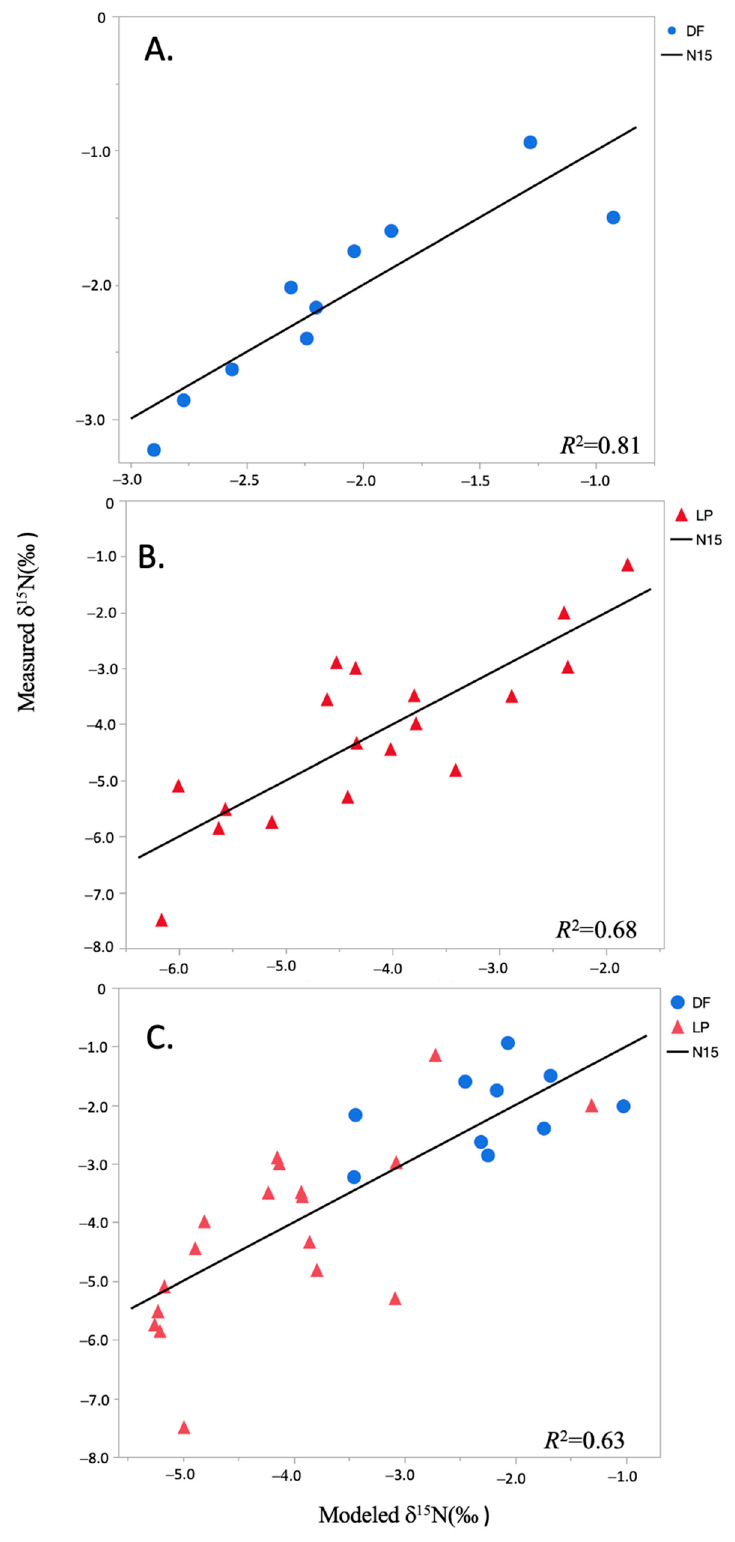
Figure 3. Multiple linear regression models predicting natural abundance foliar δ 15 N (‰) from leaf level spectroscopy for: ( A ) Douglas-fir (two-variable model); ( B ) loblolly pine (three-variable model); and ( C ) a combined data set of both species (two-variable model) (Table 4).